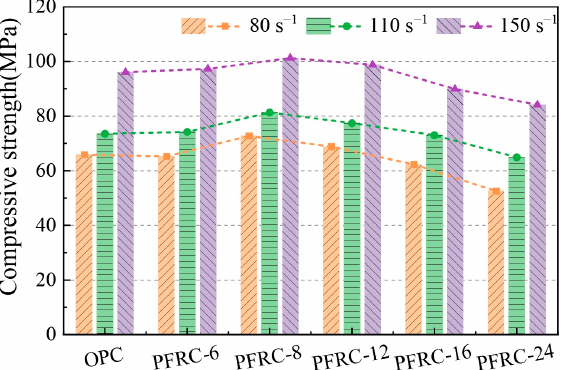
Figure 8. Dynamic compressive strength of each group of specimens at different strain rates.